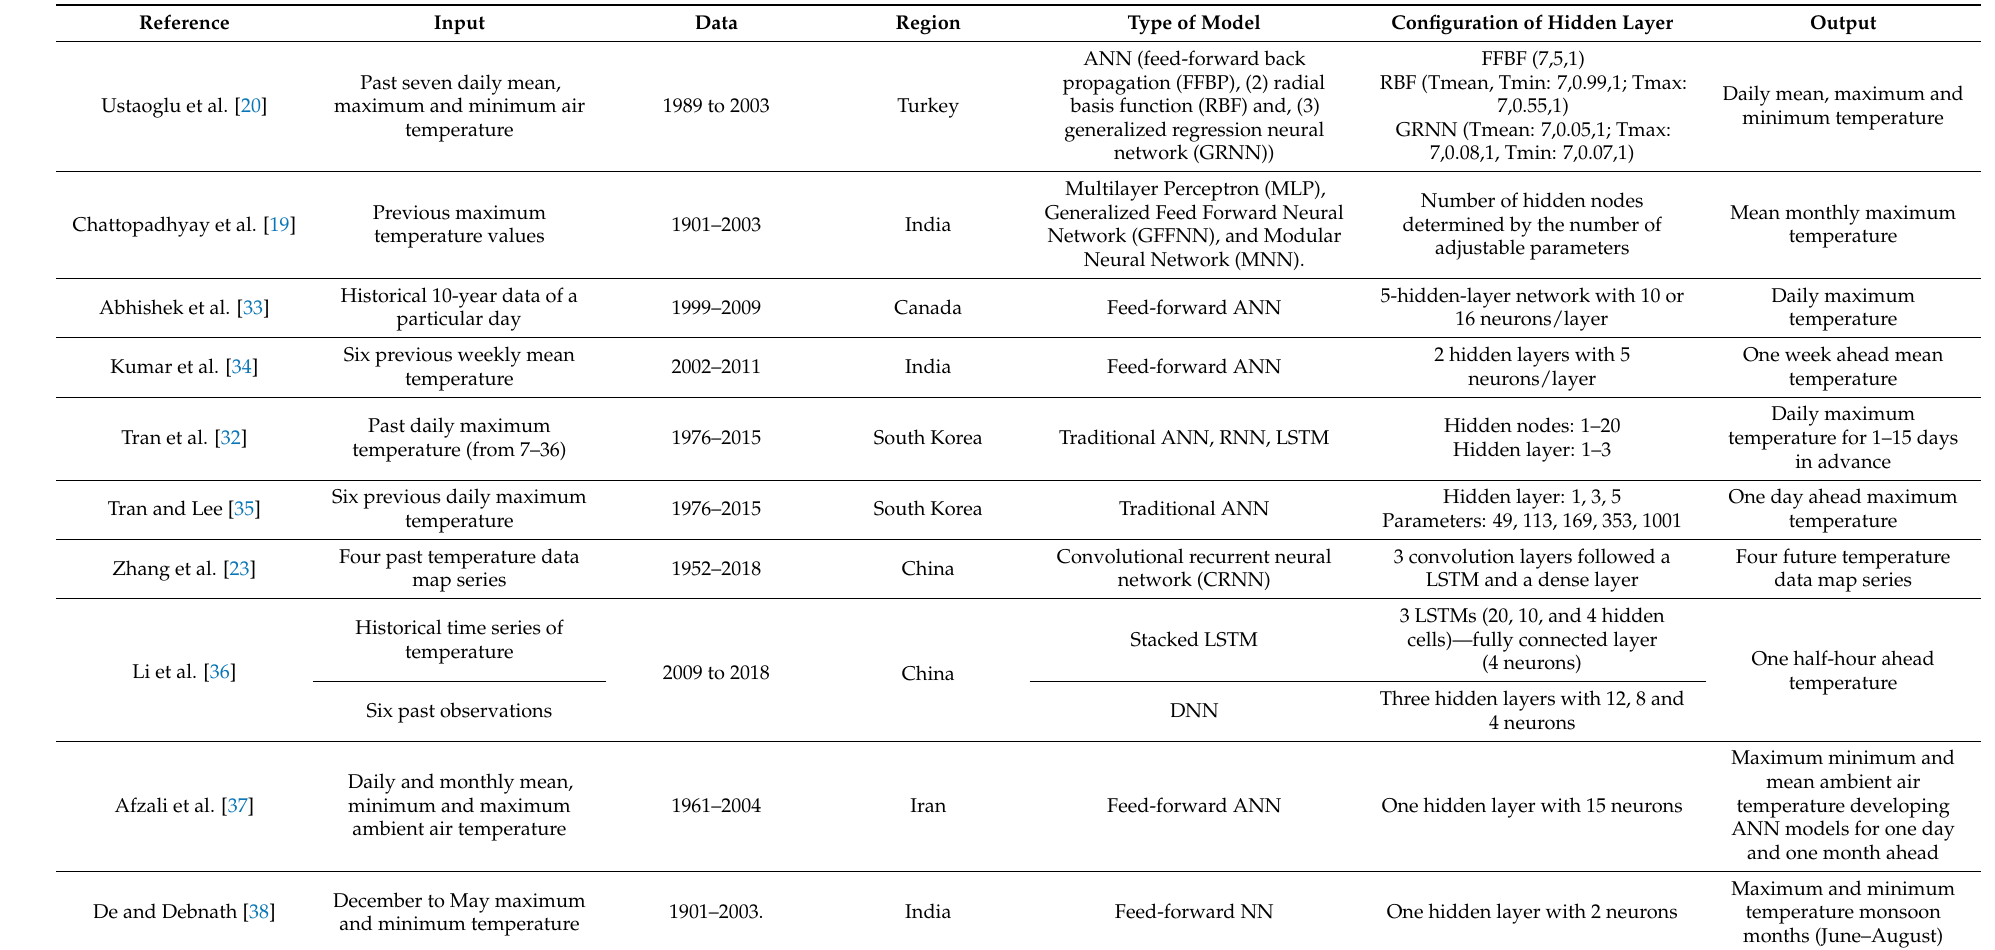
Table 1. Description of selected